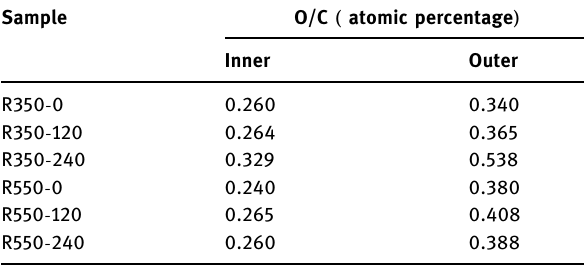
Table 2: O/C of the R350 and R550 biochar samples during ageing in soil for 0 – 240